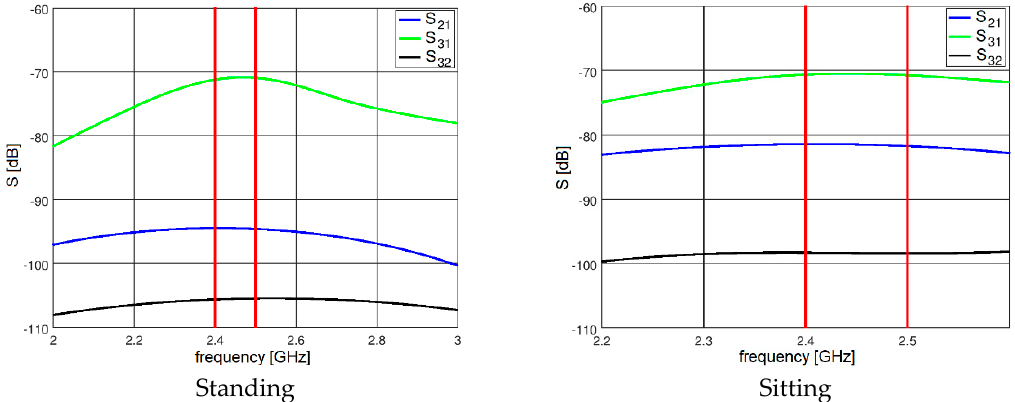
Standing Sitting Standing Sitting Figure 13. The initial S parameters. Figure 13. The initial S Figure 13. The initial S parameters. Standing Sitting Figure 13. The initial S parameters.